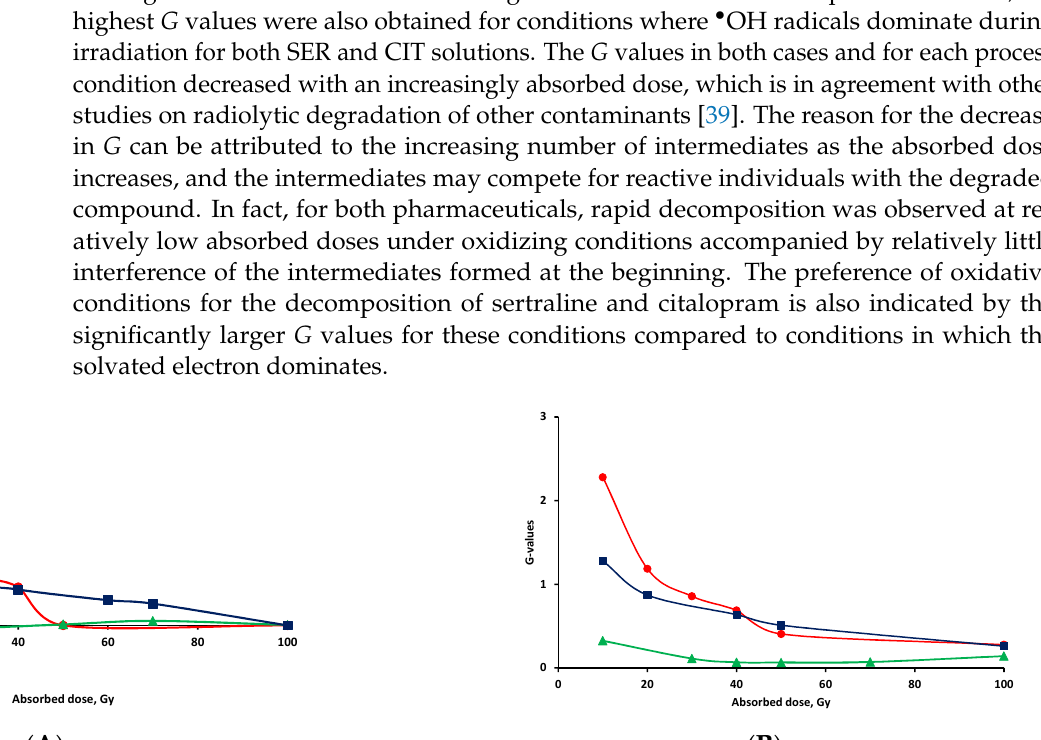
Figure 1. Efficiency of removing ADs from aqueous solution using gamma radiation under different conditions: ( A ) 10 mg/L sertraline, ( B ) 1 mg/L sertraline and ( C ) 10 m/L citalopram, ( D ) 1 mg/L citalopram. Conditions of irradiation: ( ) solution saturated with argon in the presence of t- butanol at pH 7-solvated electrons predominate, ( ● ) solution saturated with N 2 O • OH radicals predominate, ( ■ , ● ) aerated neutral solution with reactive species • OH, and O 2• − /HO 2• .